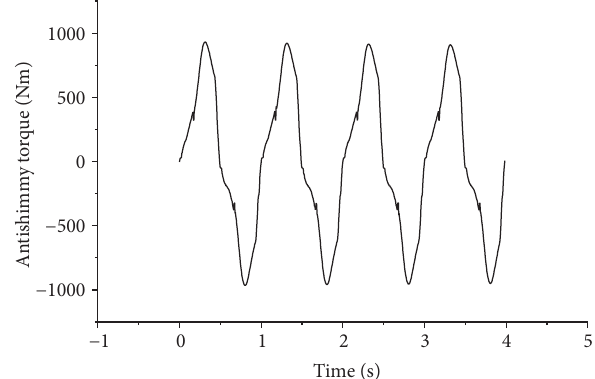
Figure 32: Antishimmy torque produced by antishimmy valves (1) .